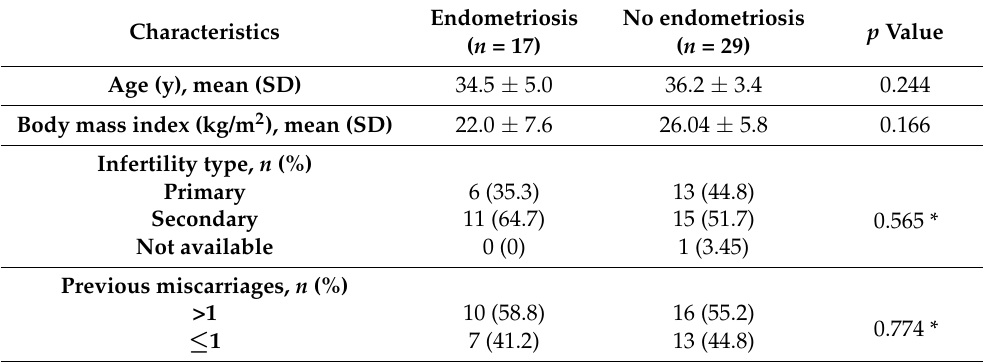
Table 2. Demographics of infertile patients with or without